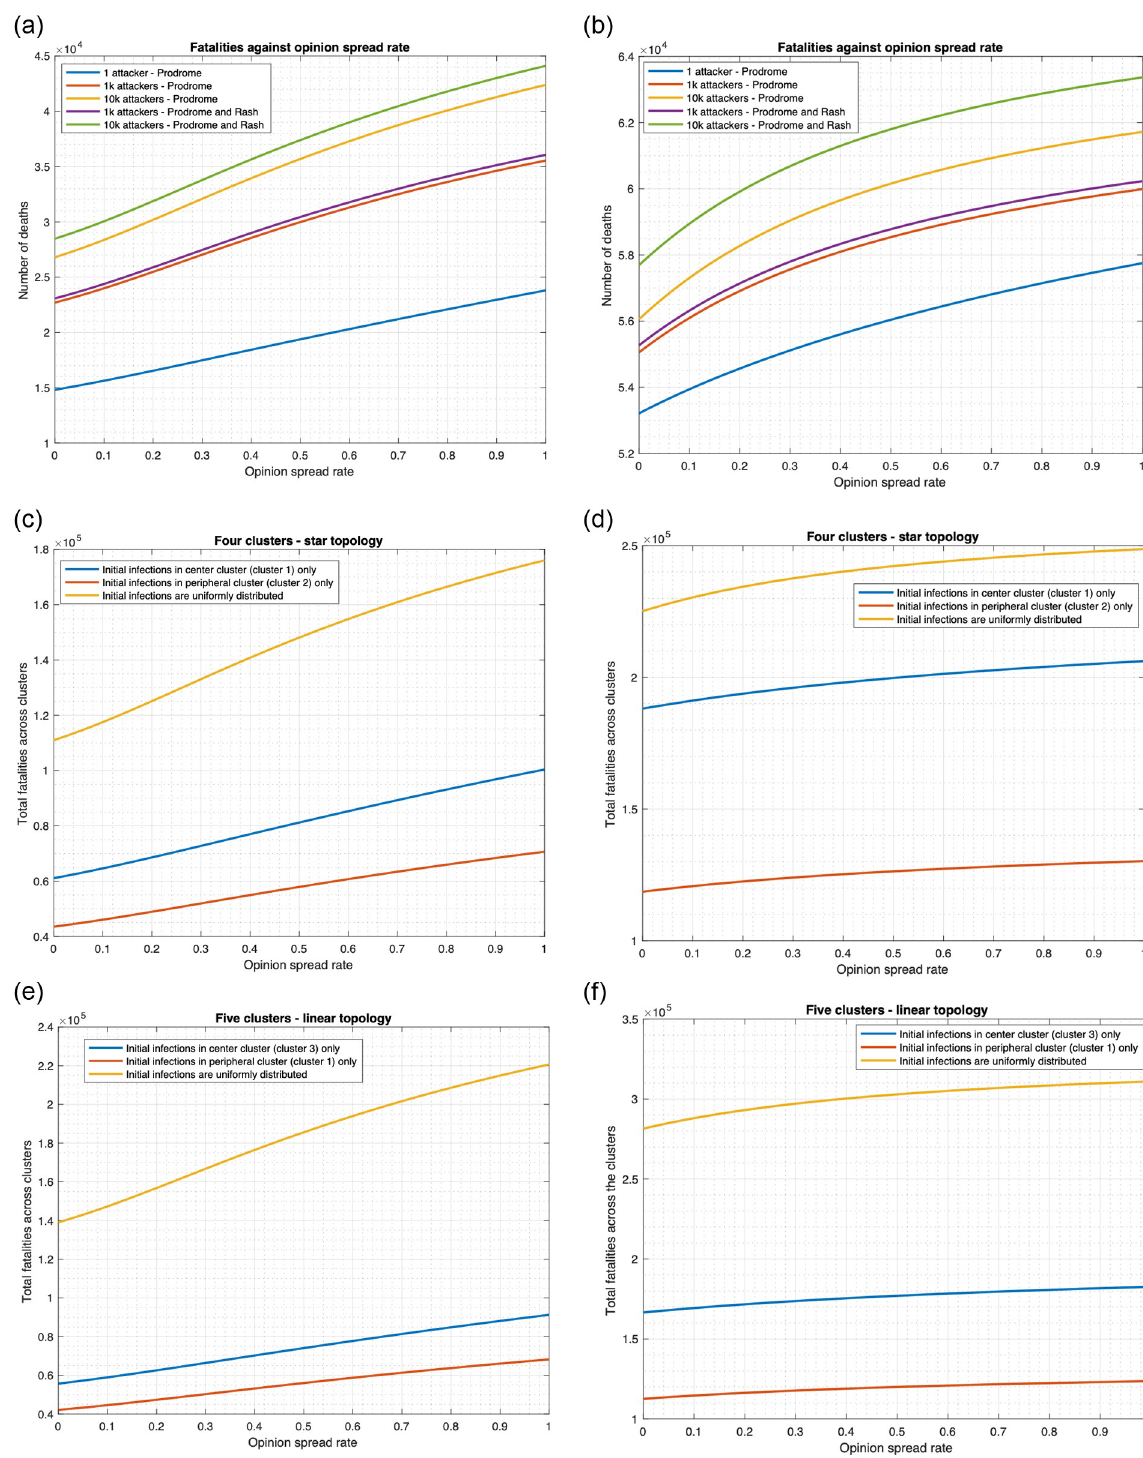
Fig 9. Relationship between fatality and opinion spread rate when non-cooperatives convert cooperatives. (a) Single cluster (initial cooperativity = 0.8). (b) Single cluster (initial cooperativity = 0.2). (c) Star topology (initial cooperativity = 0.8). (d) Star topology (initial cooperativity = 0.2). (e) Linear topology (initial cooperativity = 0.8). (f) Linear topology (initial cooperativity = 0.2).